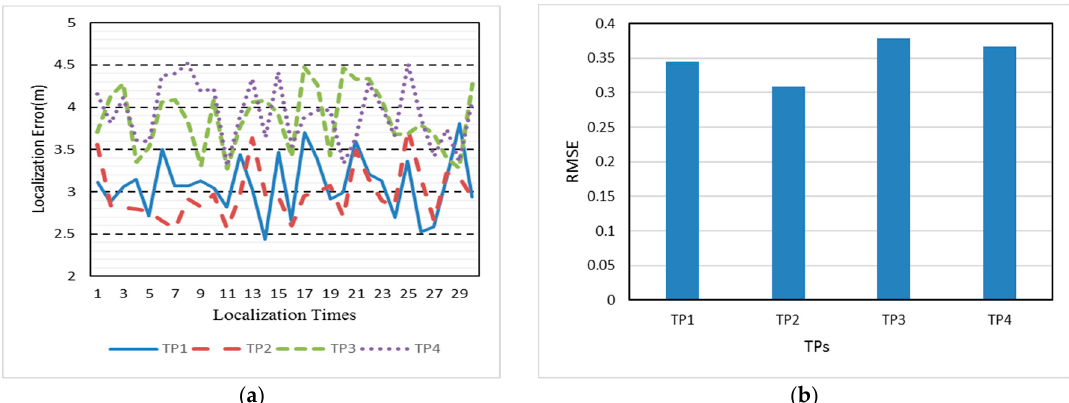
Figure 11. ( a ) Localization error of TP1 and TP2 compared to TP3 and TP4 with different situations about crowdsourcing-based points; ( b ) RMSEs of these four TPs.